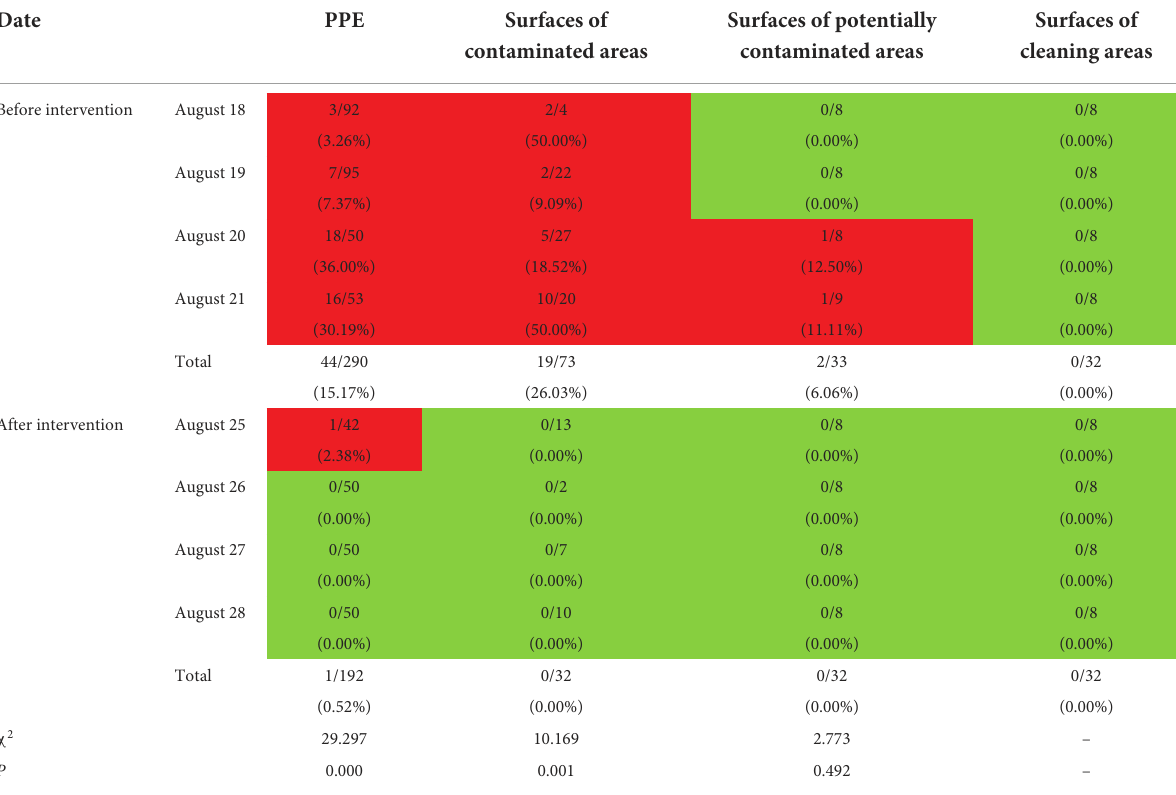
TABLE 5 Results of sampling investigation before and after